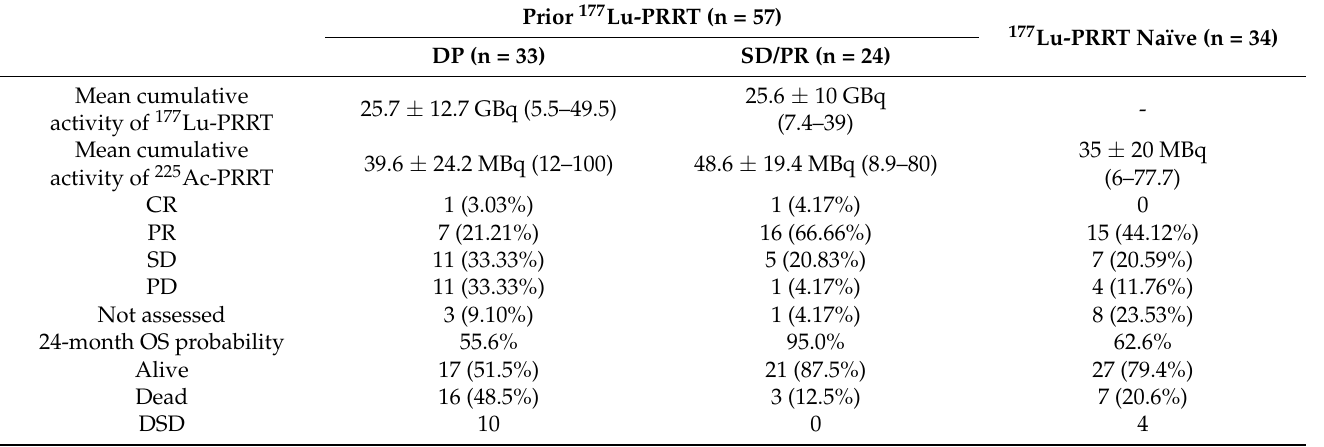
Table 6. Treatment details and response in the three groups of patients post cycles of 225 Ac– DOTATATE